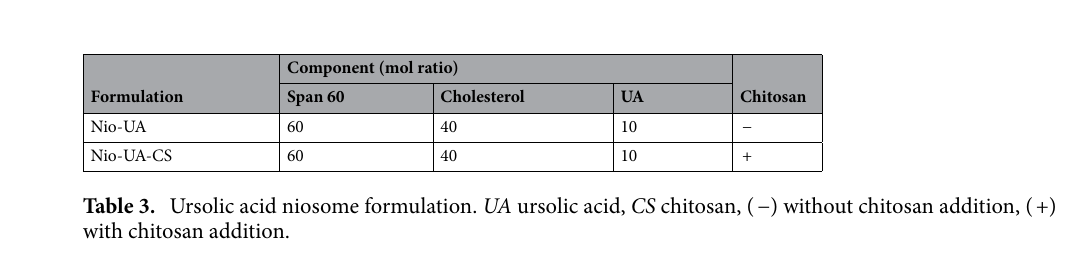
Table 2. Observations of spleen histopathological preparations of mice in the normal group, negative control, UA suspension, Nio-UA, and Nio-UA-CS equivalent to a dose of 11 mg UA/kgBW.